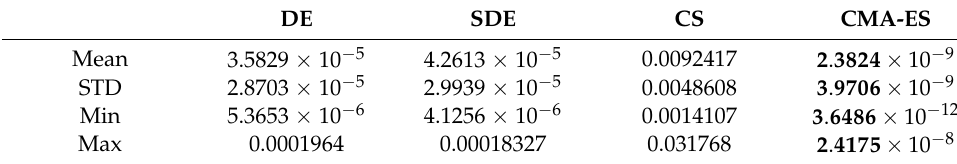
Table 11. Position error results for rose curve trajectory. The best results are highlighted in